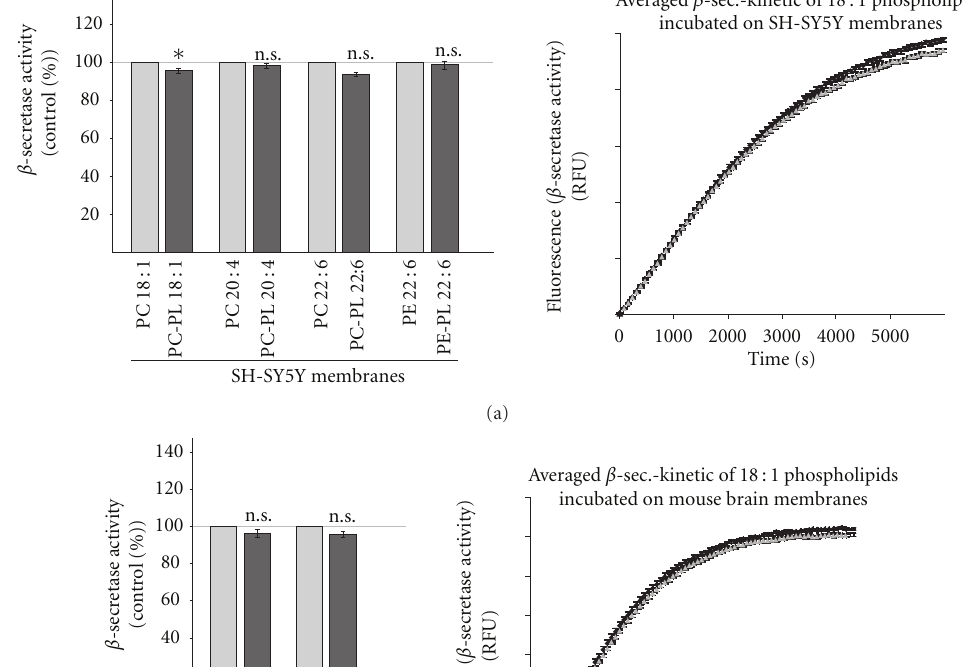
β -sec.-kinetic of 18:1 phospholipids incubated on SH-SY5Y living cells